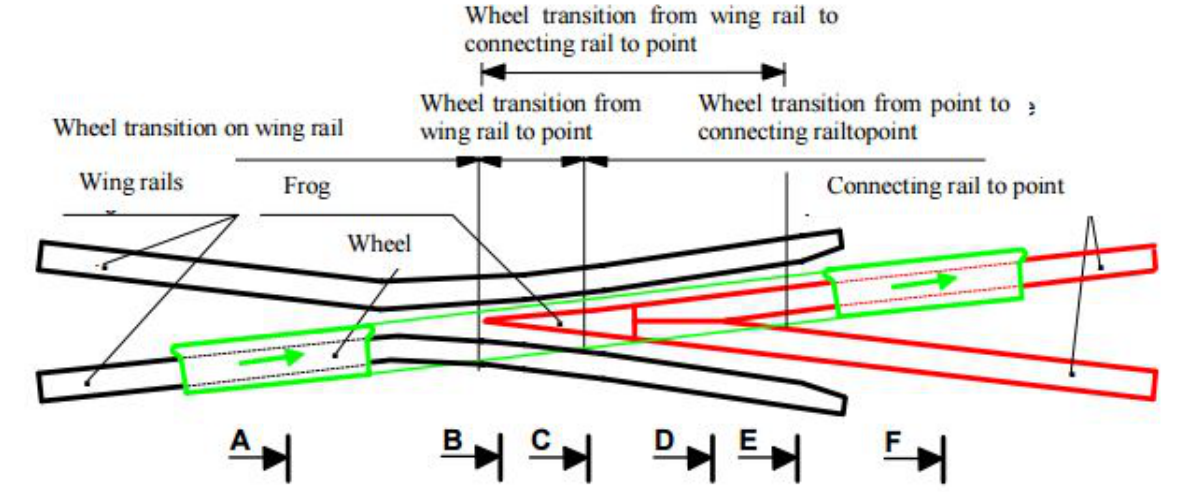
Figure 1. Schematic representation of the wheel set crossing over the frog – view from above [2].